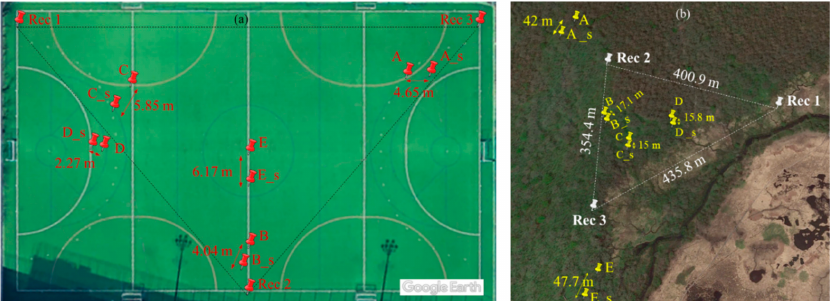
Figure 6. Google Earth images illustrate the positions of the validation points at ( a ) UTokyo ex- periment and ( b ) Oze marshland. The letters (i.e., A–E) indicate the reference positions of deer whistle and letters with “_s” represent the retrieved positions using the proposed technique. The distance between the reference and retrieve positions represents the retrieval error using the proposed technique.